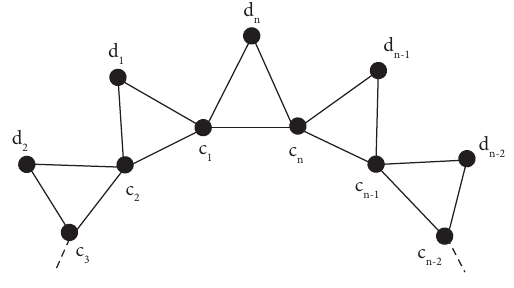
Figure 1: Te graph of M ( C